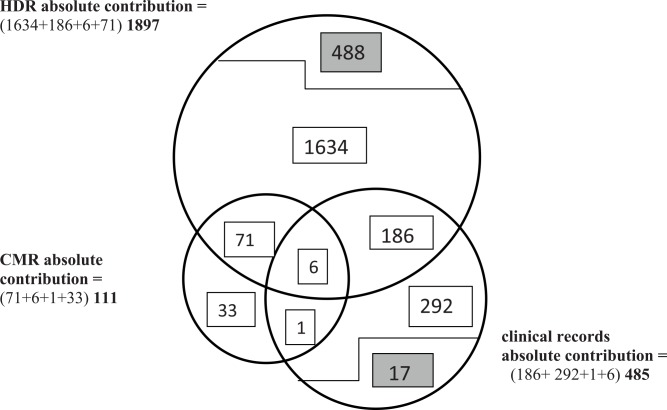
Non-proportional Venn diagram describing the absolute and the exclusive contributions in cases to COPD prevalence in 5-year longitudinal 2004–2006 period, by sources.1634 subjects hospitalized (listed in HDR) in the longitudinal period, still alive at the beginning of the prevalence period, without clinical records at the NRC Institute: enrolled as HDR exclusive contribution. 488 and 17 hospitalized subjects and outpatients respectively during 4 years preceding 2004, and deceased by the beginning of prevalence period: not included in the absolute contribution of CMR, HDR or clinical records since they had not been enrolled as prevalent cases. 186 subjects hospitalized (listed in HDR) in the longitudinal period, still alive at the beginning of the prevalence period, with clinical records also at the NRC Institute: enrolled as prevalent cases from HDR. 71 subjects deceased in the prevalence period, during or after hospitalization (HDR): enrolled as prevalent cases from HDR. 6 subjects deceased in the prevalence period, during or after hospitalizations (HDR), with clinical records as well: enrolled as prevalent cases from HDR. 292 subjects with COPD diagnosis in clinical charts or spirometry in the longitudinal period, not listed in HDR, still alive at the beginning of the prevalence period: enrolled as clinical exclusive contribution. 1 subject deceased in the prevalence period, without hospitalization (HDR) but with spirometry: enrolled as prevalent case from clinical (spirometry) records. 33 subjects deceased in the prevalence period with COPD as underlying cause, without hospitalization (not listed in HDR) or clinical records during the longitudinal period: enrolled as CMR exclusive contribution. Note: Clinical absolute contribution as reported here excludes those cases registered in common with other clinical sources.